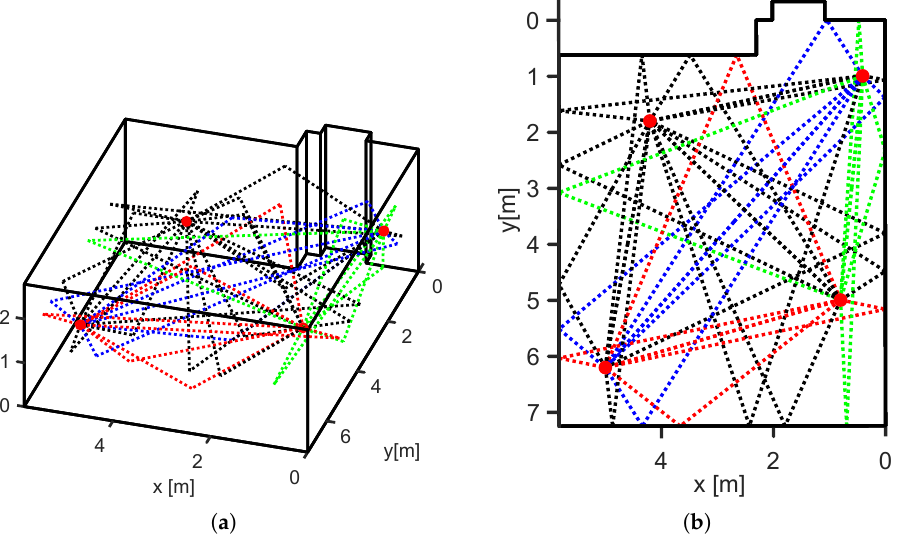
Figure 7. Raytracing for evaluation setup. ( a ) Three-dimensional room geometry of the evaluation setup with MPCs. ( b ) Top view of the 3D room geometry with